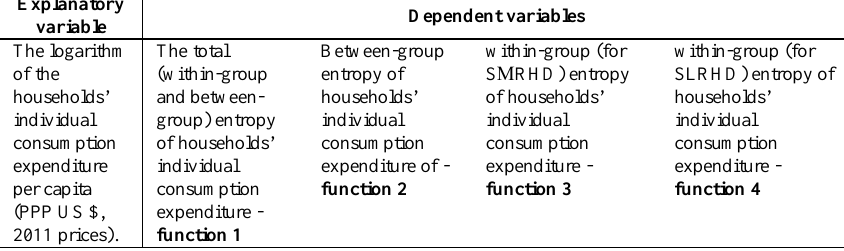
Table 2. Results of modeling for connection “size of spending – its entropy”, made